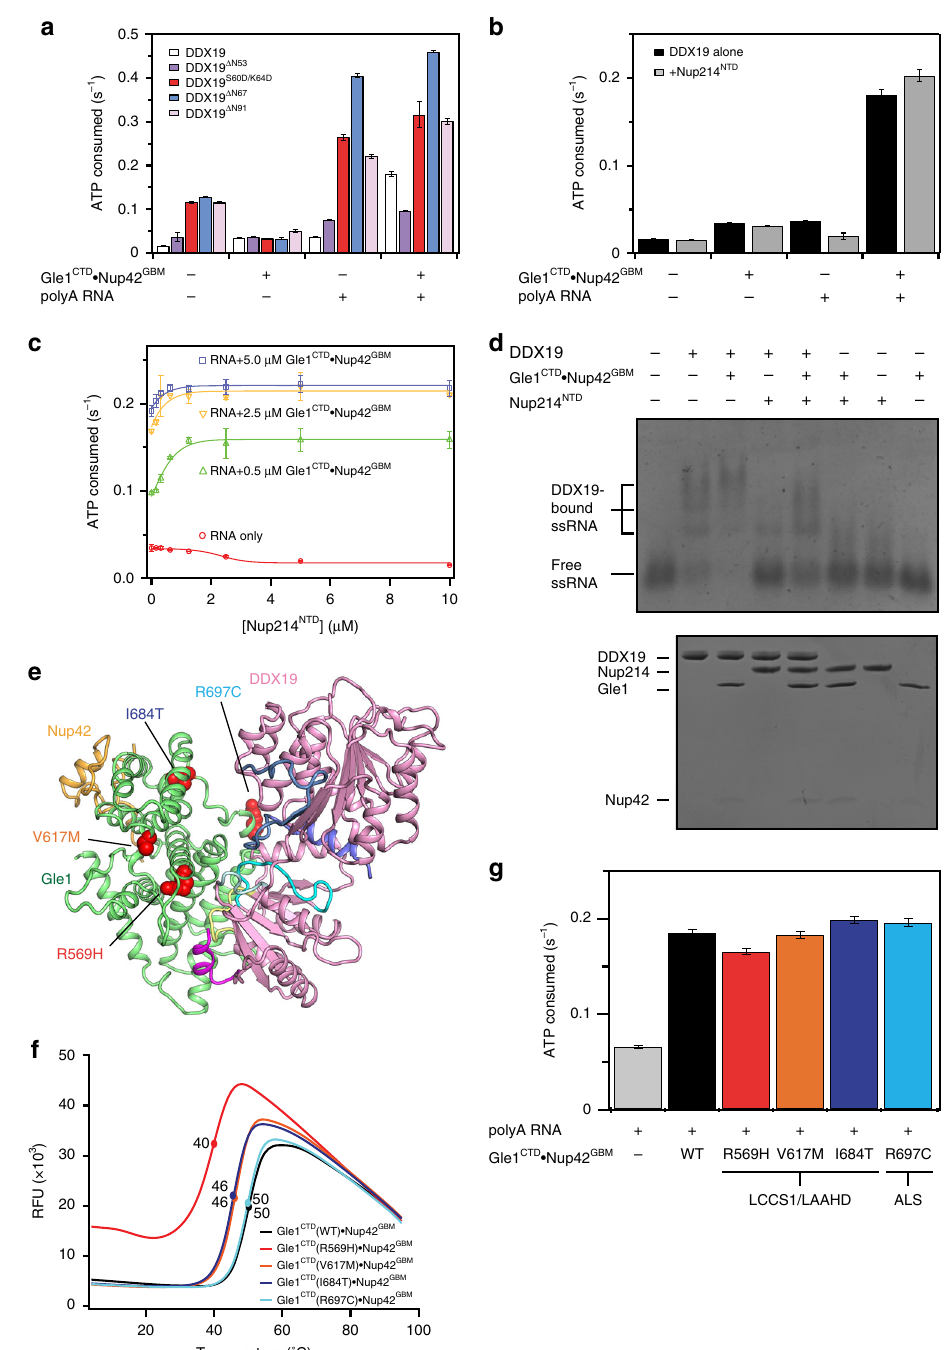
Fig. 7 Biochemical analysis of DDX19 activity. a Steady-state ATPase activity of DDX19 variants in the presence and absence of RNA and Gle1 CTD (cid:129) Nup42 GBM . For schematics of the various truncation constructs, see Supplementary Fig. 18a. b Analysis of the effect of Nup214 NTD on DDX19 stimulation. See also Supplementary Fig. 18. c Analysis of concentration dependence of Nup214 NTD on DDX19 stimulation in the presence of RNA and Gle1 CTD (cid:129) Nup42 GBM . d Electrophoretic mobility shift assay analysis of the effect of Gle1 CTD (cid:129) Nup42 GBM (1 μ M) and Nup214 NTD (2 μ M) on DDX19 (1 μ M) binding to a 53-nucleotide ssRNA. RNA was visualized by staining with SYBR gold. The proteins loaded in each lane were also visualized with a Coomassie-stained SDS-PAGE gel, shown below. e Mapping single amino acid substitutions associated with human diseases LCCS1/LAAHD and ALS onto the structure of Gle1 CTD (cid:129) Nup42 GBM (cid:129) DDX19 Δ N53 (ADP). Coloring is the same as in Fig. 5a. See also Supplementary Fig. 19. f Differential scanning fl uorimetry analysis of the effect of human disease mutations on Gle1 CTD (cid:129) Nup42 GBM stability. Exposure of hydrophobic residues monitored by an increase in relative fl uorescence units (RFUs). Curves represent the average of three experiments. g Steady-state ATPase activity of DDX19 stimulation by Gle1 CTD variants containing single amino acid substitutions associated with human disease. All reported values are the average of three experiments. Error bars indicate standard